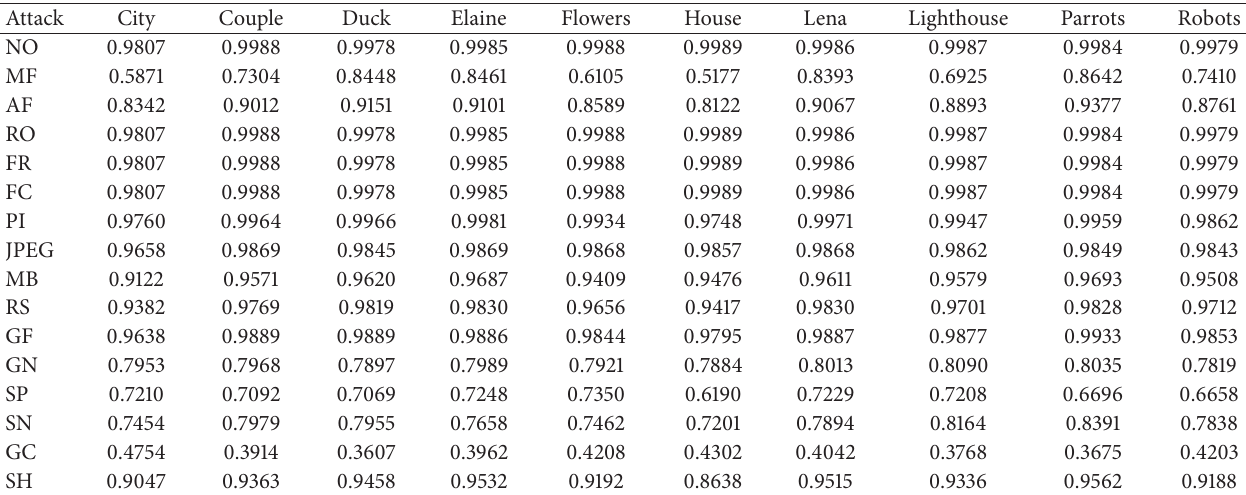
Table 3: Correlation values of the extracted watermarks by the proposed scheme corresponding to WM2.